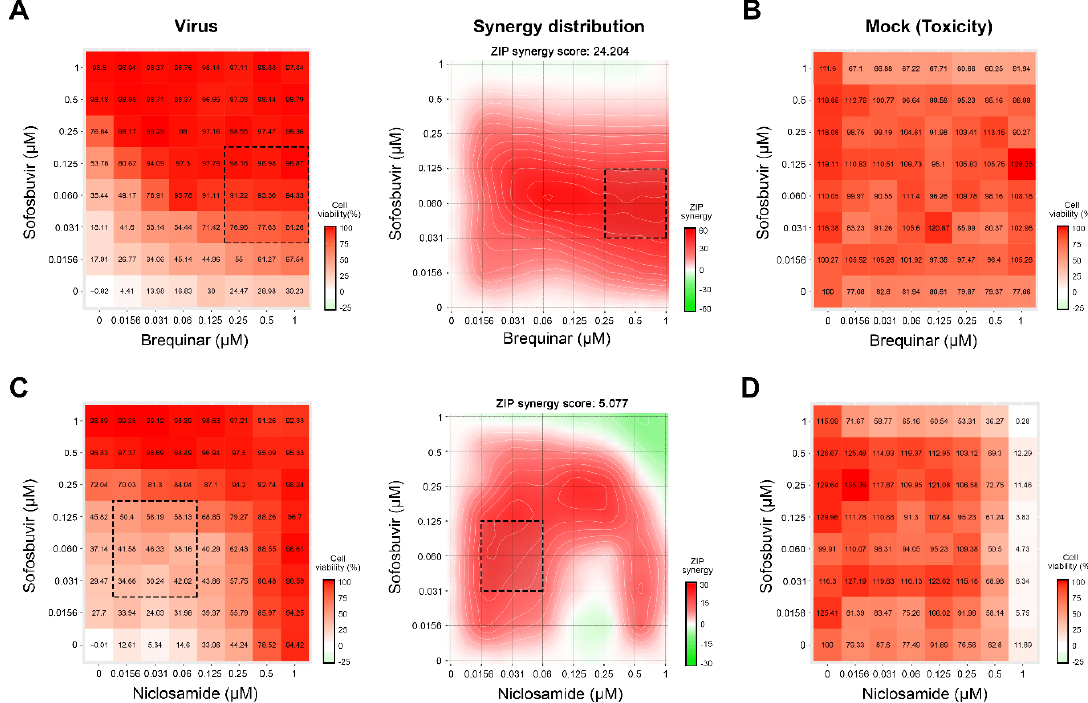
Figure 4. Combination of sofosbuvir and brequinar or niclosamide inhibit HCV-mediated GFP expression in Huh-7.5 cells. ( A , C ) The interaction landscapes measured using a GFP-expressing reporter virus. ( B , D ) The interaction landscapes of two drugs measured using CTG assay on mock-infected cells.